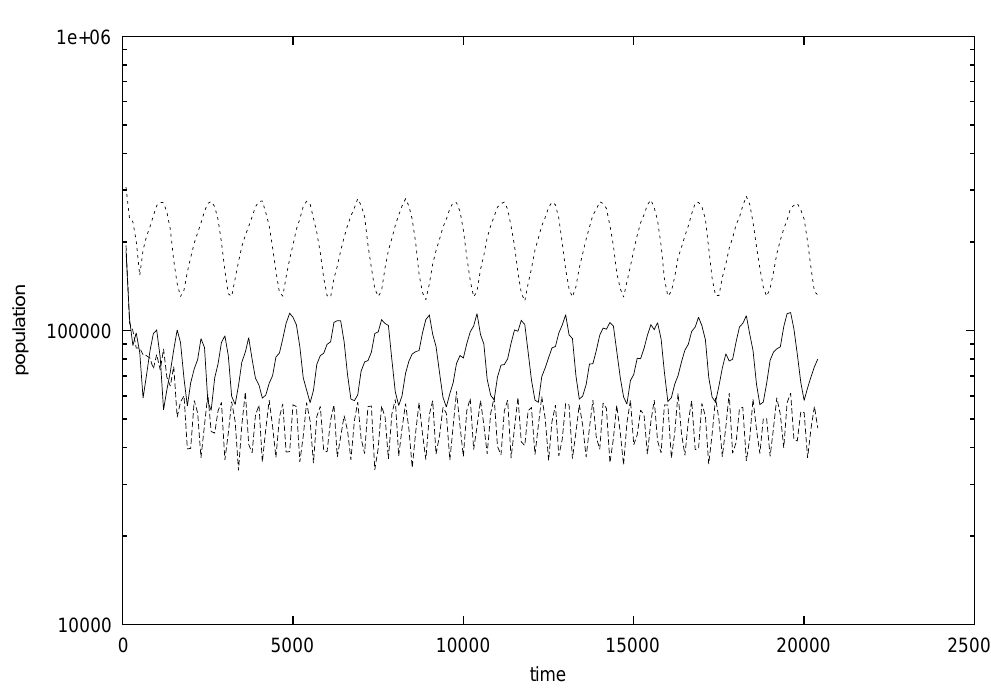
Fig. 6 – Can partner selection overcome the loss of half the births? The top data show step 1, the bottom data step 2, and the middle data step 3 (see text): Selection helps, but not